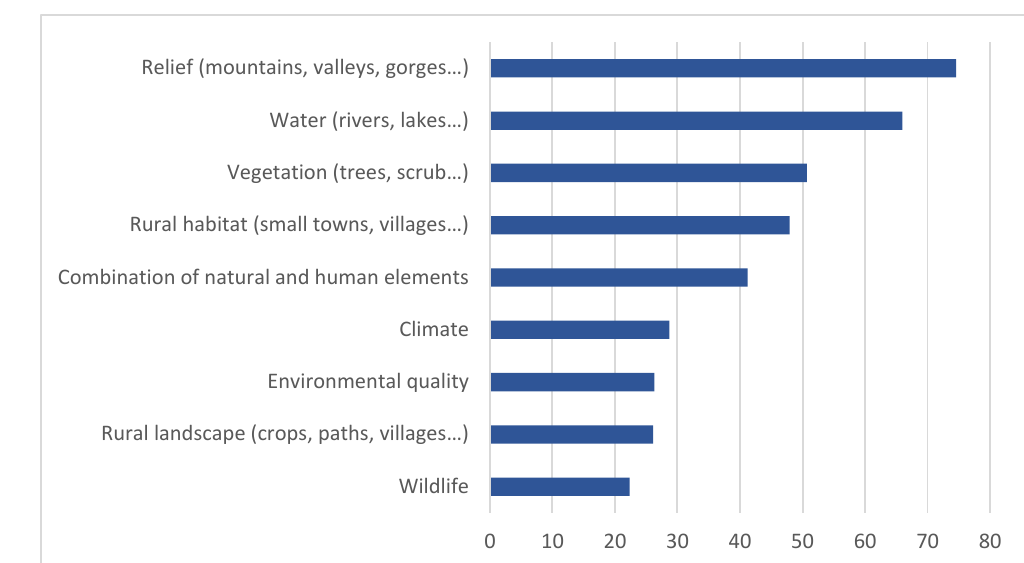
Figure 1. Elements that mark the character of the landscape in the Albacete mountains (% of respondents). (Source: Own preparation).